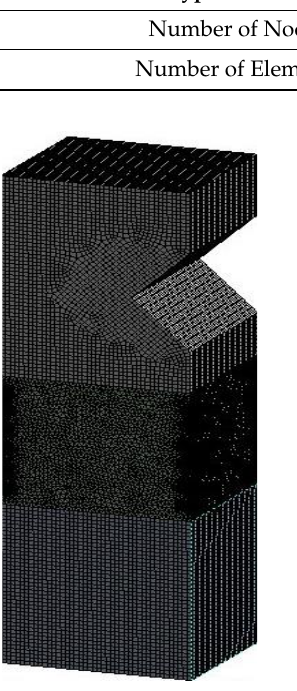
Table 5. Supercritical boiler meshing details.